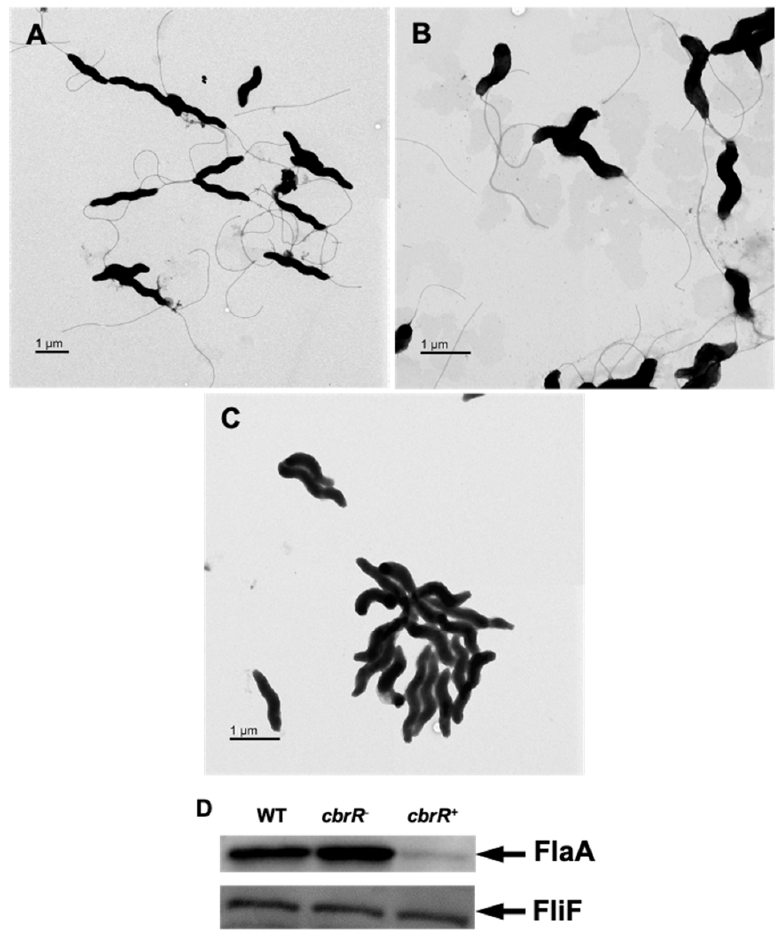
Figure 4. Flagellar expression is decreased with higher levels of CbrR. TEM images of WT cells ( A ) possess two polar flagella, as expected, as do cbrR − cells ( B ). However, overexpression of CbrR leads to the absence of flagella in cbrR + cells ( C ). This was confirmed via Western blot probing for FlaA in cell lysate from each strain, which showed greatly decreased expression of FlaA in cbrR + cells ( D ). Western blots using antibodies to FliF, which is expressed equally in these strains, confirmed equivalent loading of the samples.